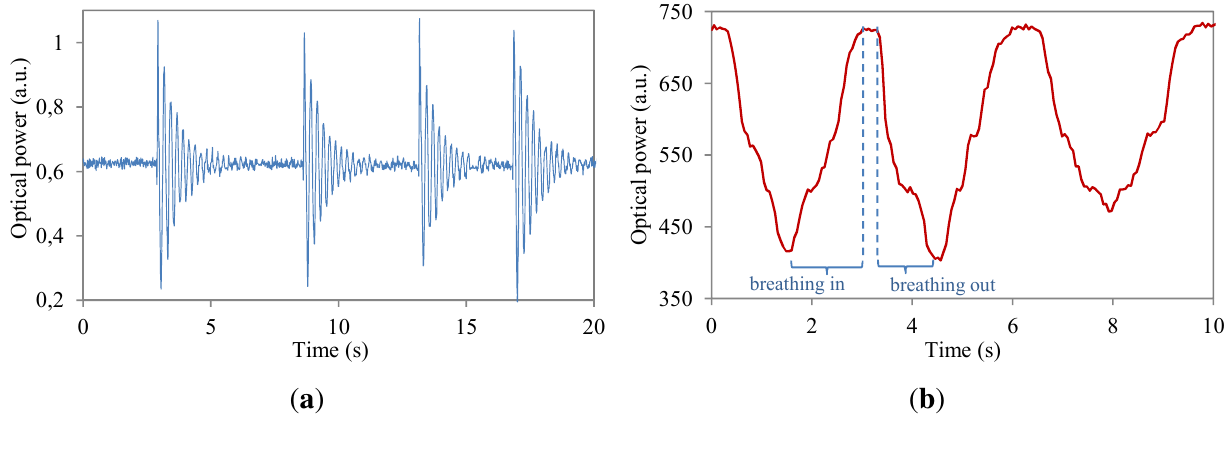
Figure 7. Proof of concept characterization results. ( a ) Transmitted power oscillations resulting from a downward touching force at 2.9 s, 8.7 s, 13.2 s and 16.9 s; ( b ) Breathing movement system